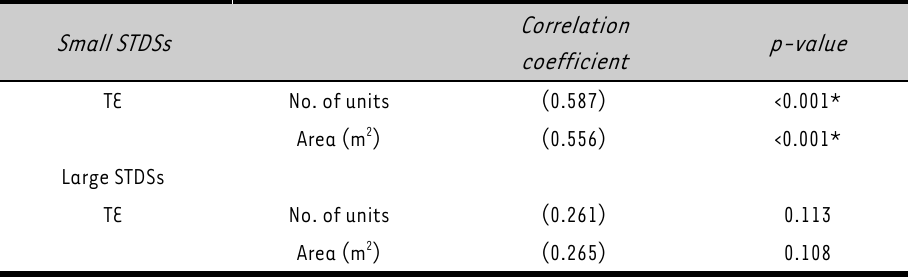
Correlation coefficient (r) and p-values Small STDSs